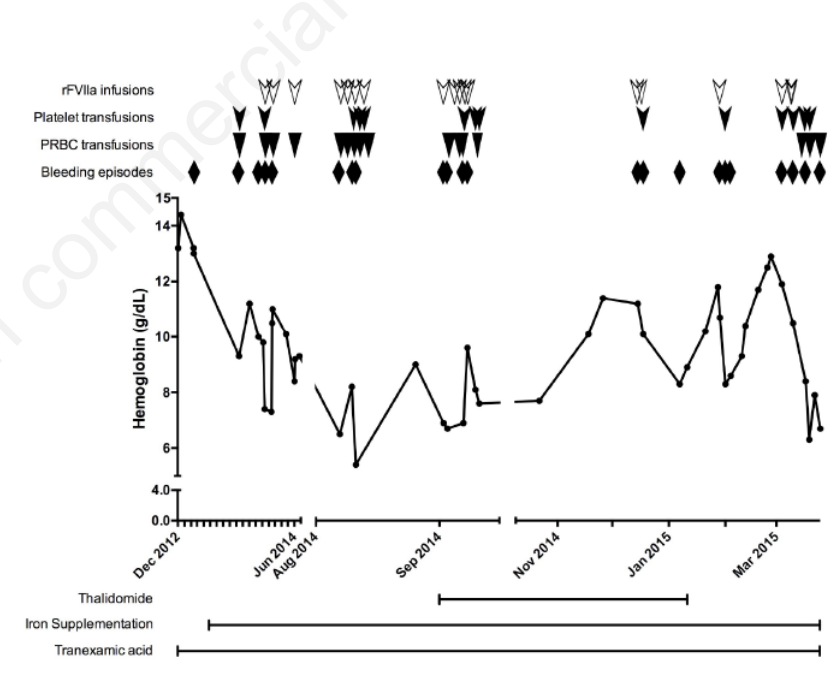
Figure 1. Patient’s hemoglobin evolution during follow-up. Patient initially presented at another hospital with severe GI bleeding (data not available and not shown) in November 2012. She started follow-up at our clinic soon after, in December 2012. She developed several bleeding episodes during the following months requiring transfusion of different blood products. With the introduction of thalidomide in September 2014, a reduction in the number of bleeding episodes was observed, with no transfusion requirements during this period. In mid-January 2015, however, bleeding relapsed and she was taken of thalidomide. After placement of a peripherally inserted central venous catheter for intra- venous iron infusions, she developed sepsis and died. PRBC: packed red blood cells; rFVIIa: recombinant activated factor